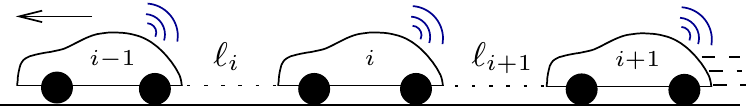
Figure 1. Vehicle platoon with a predecessor-following topology and wireless